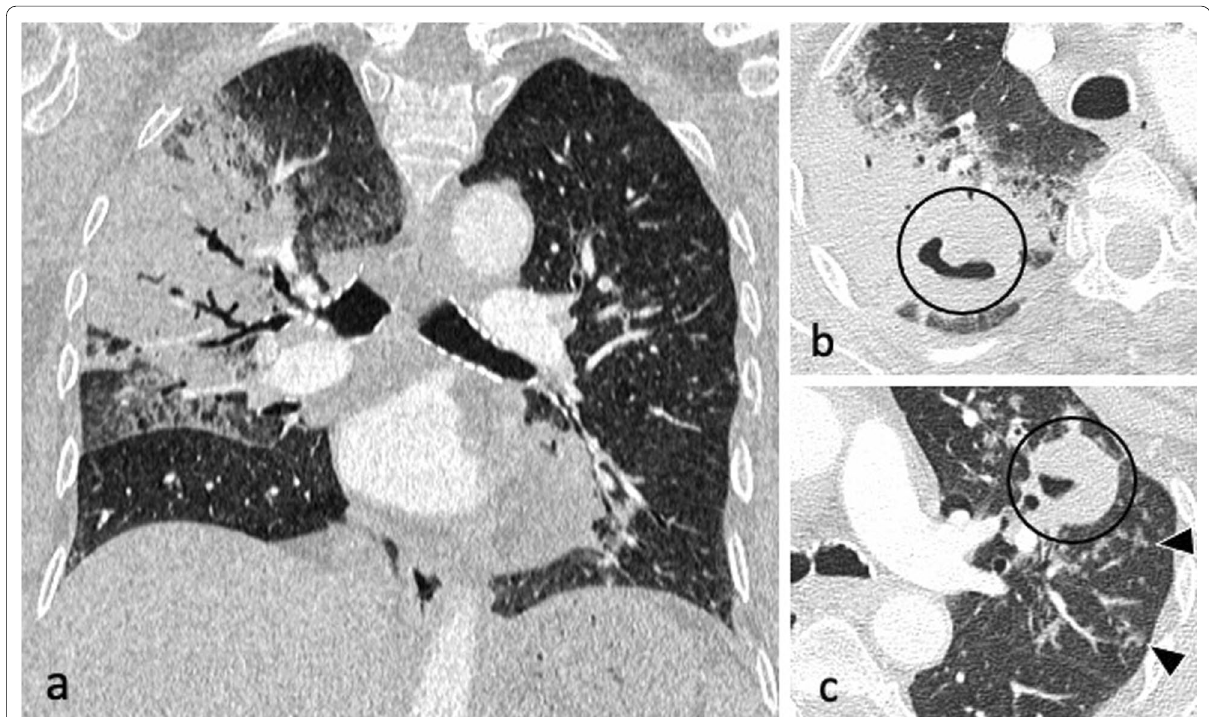
Fig. 2 An 83-year-old male presented with pyrexia of unknown origin. CT (lung window) demonstrates extensive consolidation in the right upper lobe (coronal plane— a ), bilateral thick-walled cavities (axial planes— b , c , circled) and centrilobular nodules with a tree-in-bud appearance